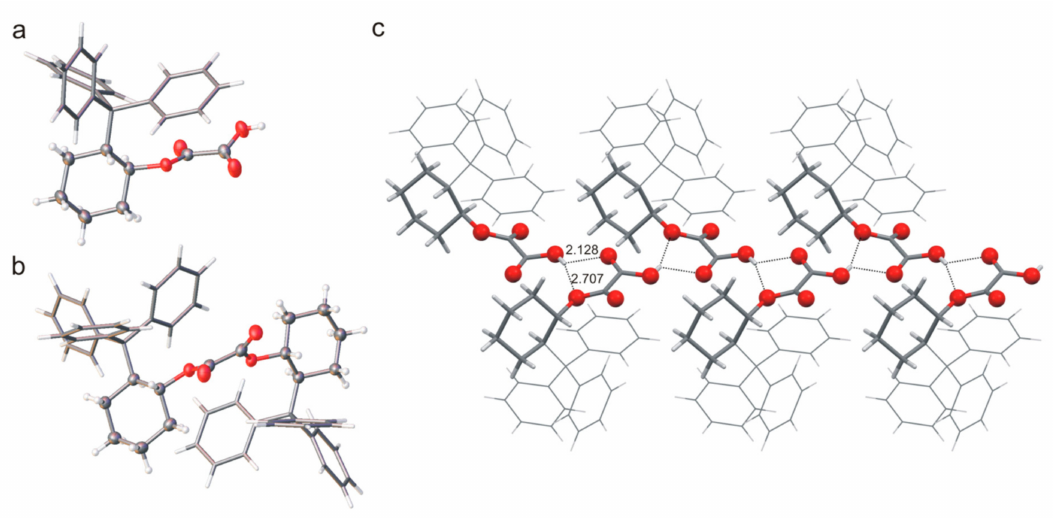
Figure 6. Molecular structure of ( a ) compound 7 , ( b ) compound 9, and ( c ) supramolecular chain via hydrogen bonds in structure 7 (hydrogen bonds showed as a dashed line). The oxygen atoms are shown as